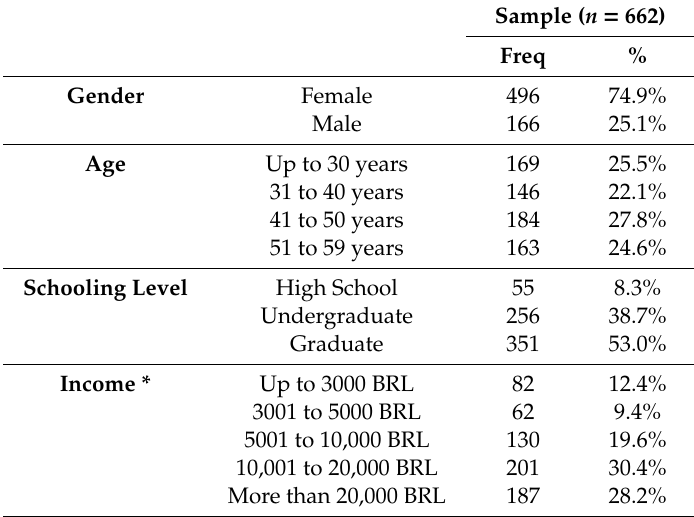
Table 2. Socio-demographic characteristics of the individuals ( n = 662, Federal District,